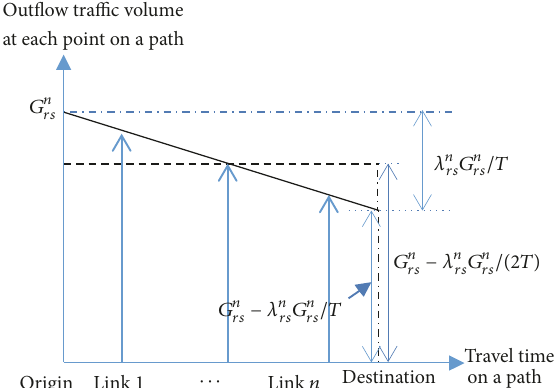
Figure 1: Modification image of residual demand at the end of period in OD modification